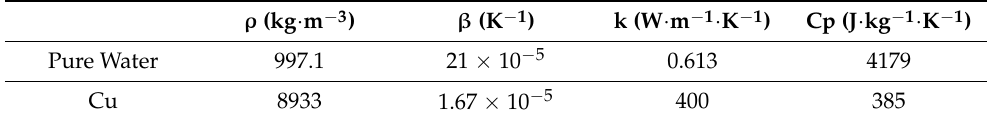
Figure 1. Physical domain ( a ) and the mesh generation ( b ) of the considered problem. Table 1. Thermo-physical characteristics of pure water and nanoparticles [50].